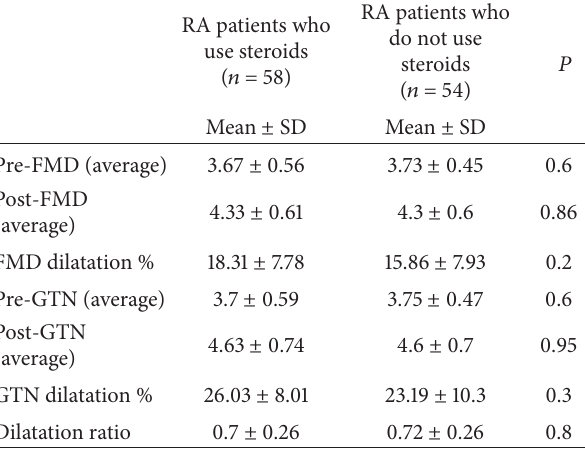
Table 13: Comparison of parameters which assess the endothelial function in RA patients who use steroids and RA patients who do not use steroids.